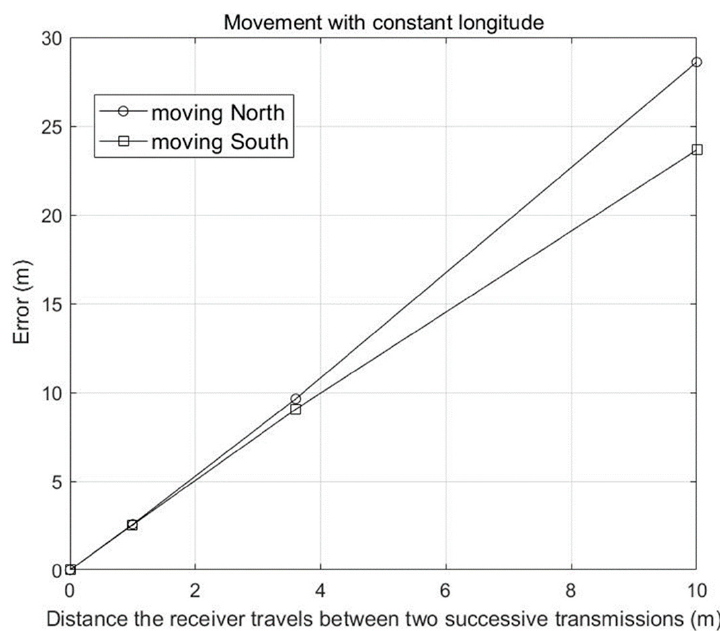
Figure 4. Error when the receiver is moving along a meridian.